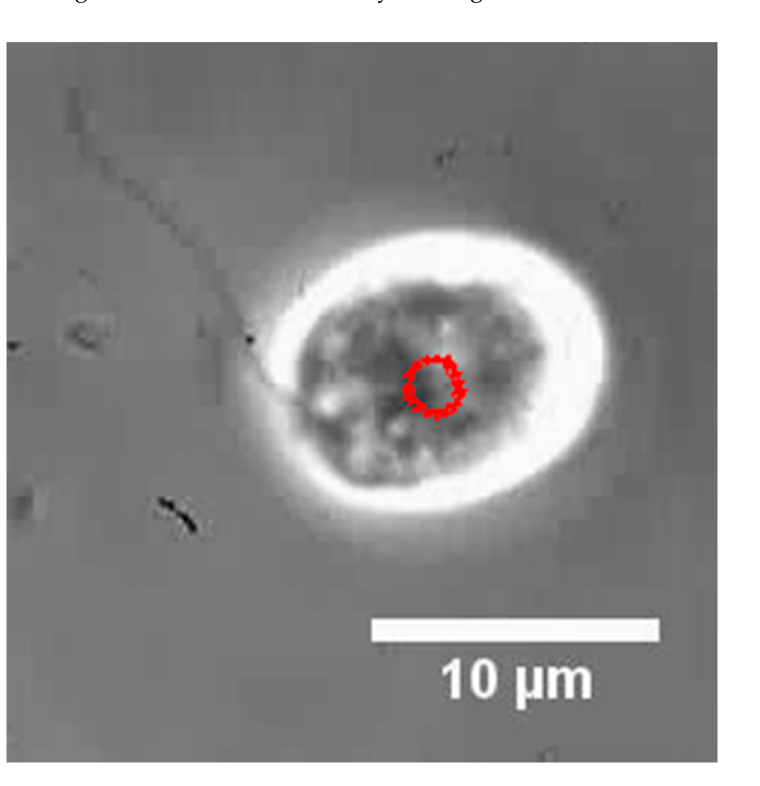
Figure 9. C. reinhardtii with only one flagellum removed. Red dots are the trajectory of the revolution motion. See the Supplementary Video S1.